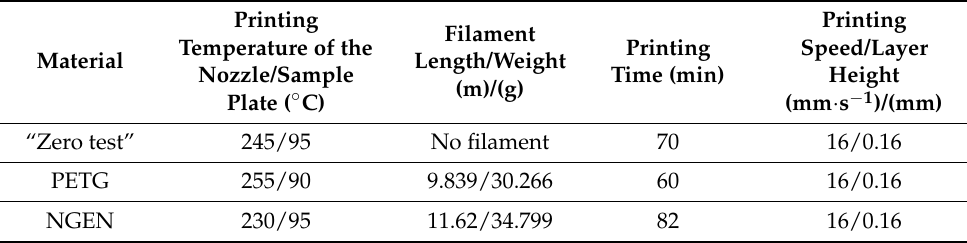
Table 2. Summary of conditions of ultrafine particles (UFP) tests performed. Printing Temperature of the Material Nozzle/Sample Plate ( ◦ C) “Zero test”